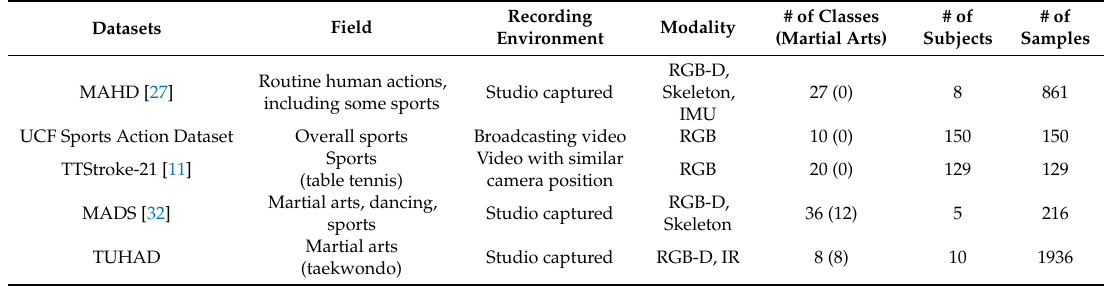
Table 9. The comparison between datasets containing sports and martial